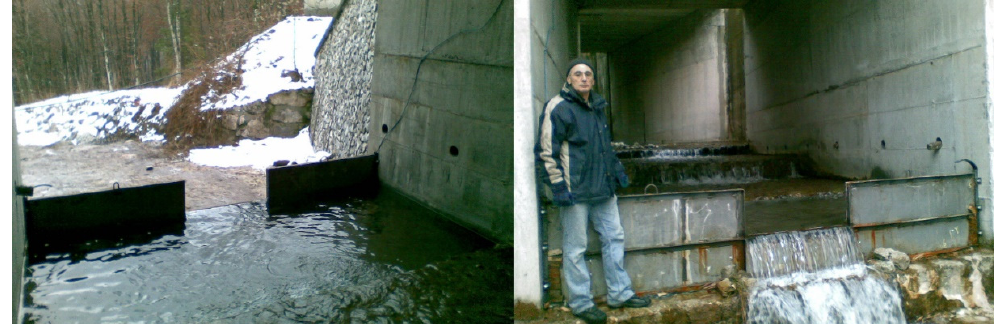
Figure 5. Thin plate weir on the Rio Verde torrent seen from upstream ( left ) and downstream ( right ).